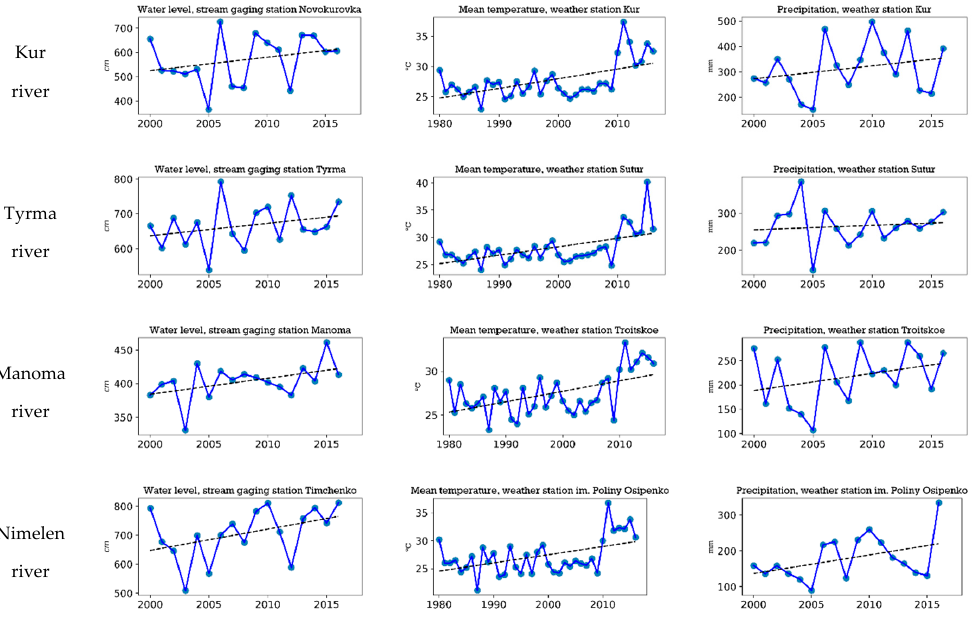
Figure 6. Discharge, run-off coefficient and water level for July–August 2000–2016 on watersheds: Amgun rivers, Bureya rivers, Bira